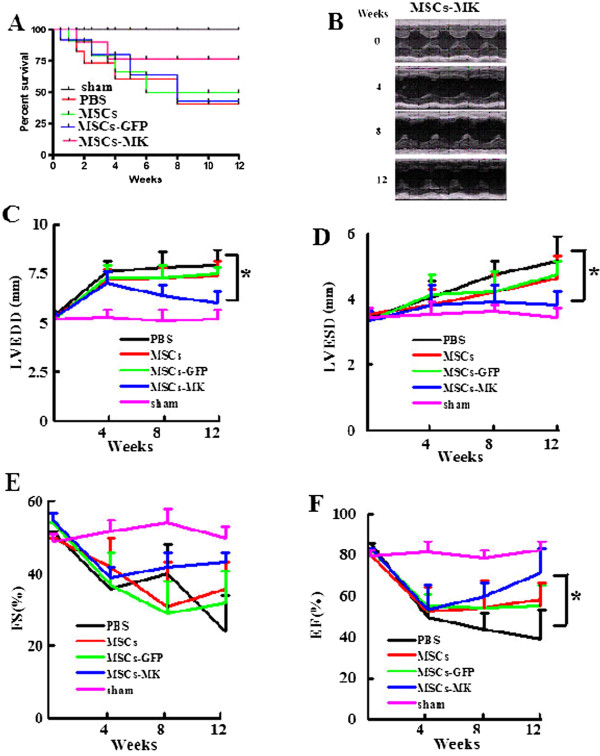
Curative effect evaluation of MSCs-MK by echocardiography in rats after myocardial infarction. A: Survival rate estimated by the Kaplan-Meier method in sham rats (sham; n = 12, none died), MI rats treated by PBS (PBS; n = 12, 7 died), MI rats treated with MSCs (MSCs; n = 12, 6 died), with MSCs-GFP (MSCs-GFP; n = 12, 7 died) and with MSCs-MK (MSCs-MK; n = 12, 3 died). Survival rates of MSCs-MK were significantly higher than for MSCs and MSCs-GFP. B: Representative echocardiography findings in the MSCs-MK group before MI (pre-operation) and 4, 8 and 12 weeks after MI (post-treatment). C, D, E and F: Measurements were performed at baseline before MI and 4, 8 and 12 weeks after MI, as indicated. (C) Left ventricular end-diastolic diameter (LVEDD). (D) Left ventricular end-systolic diameter (LVESD). (E) Fractional shortening (FS). (F) Ejection fraction (EF). *indicates p< 0.05 vs. the PBS group at the same time-point, one-way ANOVA. All values represent mean ± SEM. MI, Myocardial infarction; MSCs-GFP, Mesenchymal stem cells-green fluorescent protein; MSCs-MK, Mesenchymal stem cells-midkine.